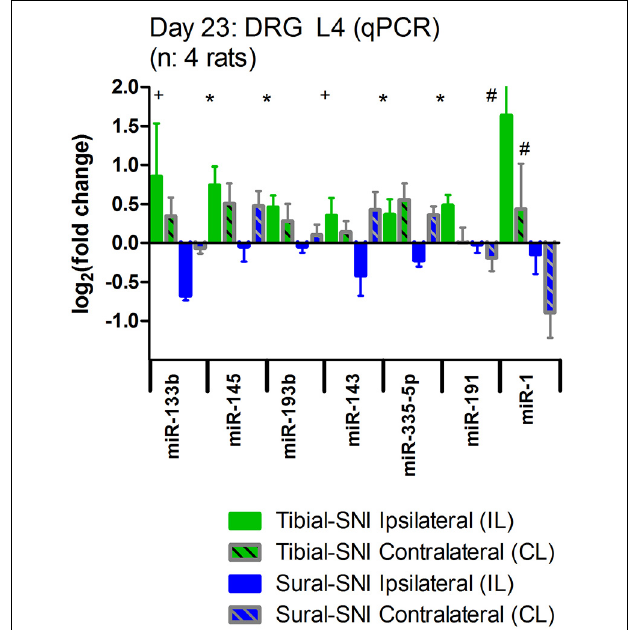
FIGURE 5 | Nerve injury also evokes changes in miR expression in the contralateral DRG. The expression level of the seven identified miRs is shown for the ipsilateral L4-DRG (IL) and from the contralateral L4-DRG (CL) derived from Sural-SNI and Tibial-SNI. The seven miRs showed differential regulation in the ipsilateral L4-DRG between the two SNI variants (as shown in Figure 4C ). Compared to values of DRG derived from Sham animals (which in the graph corresponds to 0) these seven miRs also showed changes in regulation in the contralateral L4-DRG. These changes were comparable in the two SNI variants, only being significantly different for miR-1. Significant difference between Sural-SNI L vs. Tibial SNI-L or between Sural-SNI CL vs. Tibial-SNI CL: ∗ P < 0 . 02, + P < 0 . 05, # P < 0 . 09, Unpaired t -test,